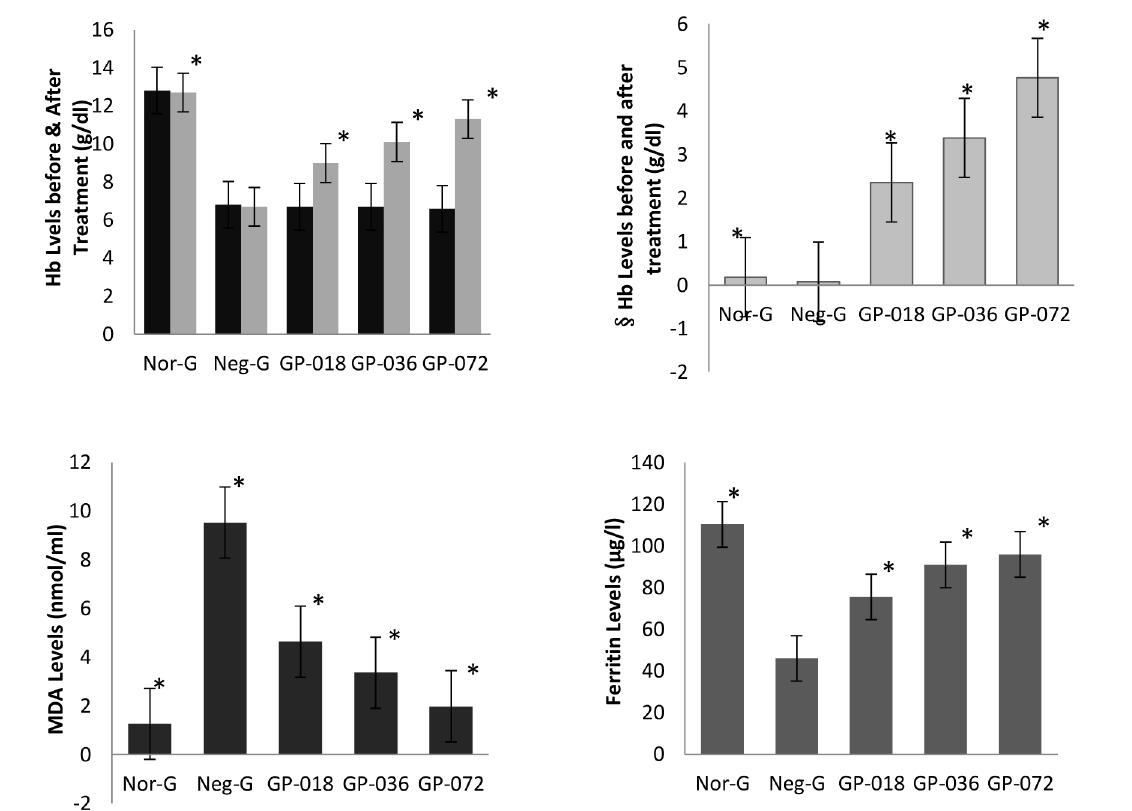
Figure 1. Level of Haemoglobin, §Hb before and after treatment, Ferritin, and MDA in each groups. * Significantly difference compared to that of